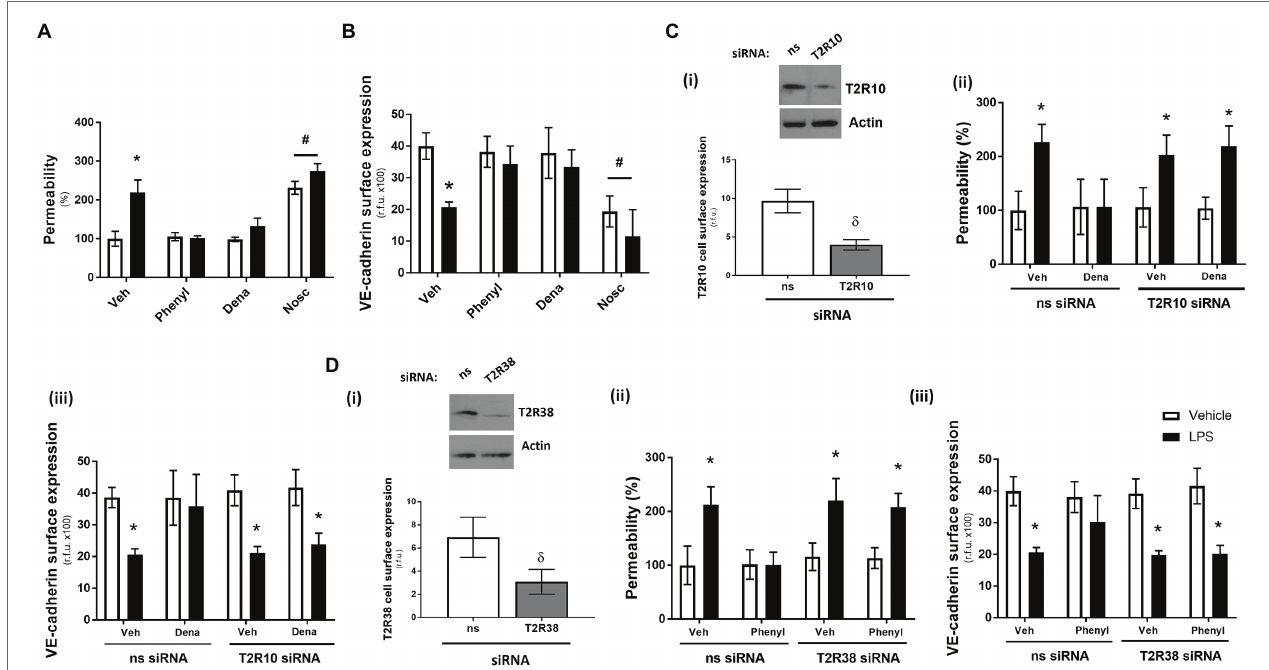
FIGURE 1 | Denatonium (Dena) and phenylthiourea (Phenyl) protect against LPS-induced permeability and VE-cadherin internalisation in human pulmonary arterial endothelial cells by acting directly through T2R10 and T2R38, respectively. Panels A and B: HPAEC were exposed to noscapine, denatonium or phenylthiourea (0.1 mm) in the presence (closed bars) or absence (open bars) of LPS (1 μ g/ml) for 24 h. Monolayer permeability was measured using the FITC-dextran essay (panel A ) and VE-cadherin surface expression was assessed using whole cell ELISA (panel B ). Panels C and D: T2R10 (panel C )- and T2R38 (panel D )-specific siRNA was used to knockdown expression in HPAEC and confirmed using Western blot (inset) and whole cell ELISA [panels C (i) and D (i)]. Denatonium or phenylthiourea (0.1 mm) was added after 24 h in the presence (closed bars) or absence (open bars) of LPS (1 μ g/ml) and monolayer permeability [panels C (ii) and D (ii)] and VE- cadherin surface expression [panels C (iii) and D (iii)] were studied. Data are presented as mean ± S.D. n = 6. Panel * p < 0.05 versus vehicle for LPS; # p < 0.05 versus vehicle for bitter agonists; δ p < 0.05 versus non-specific siRNA.